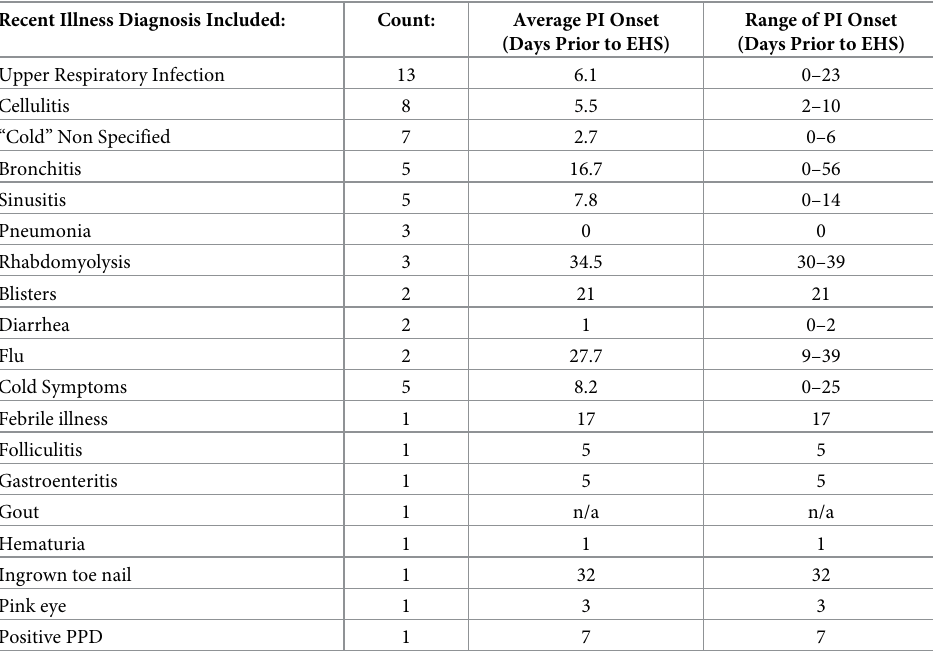
Table 3. Number and type of recent illness documented. Recent Illness Diagnosis